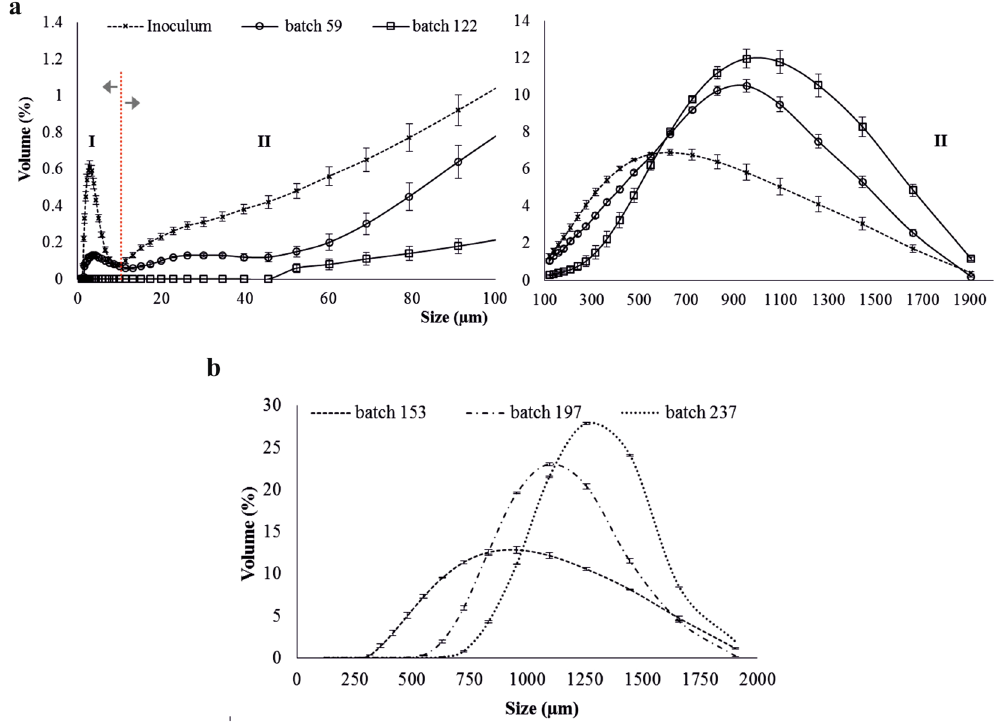
Figure 3. Size evolution of the activated algae granules. ( a ) Volume distribution of the target microalgae cells size ( section I ) and activated algae flocs size ( section II ) during the granulation procedure (the first 122 batches). ( b ) Dynamics of the volume distribution curve of the activated algae granules size recorded for the following culturing batches: 153, 197, and 237.